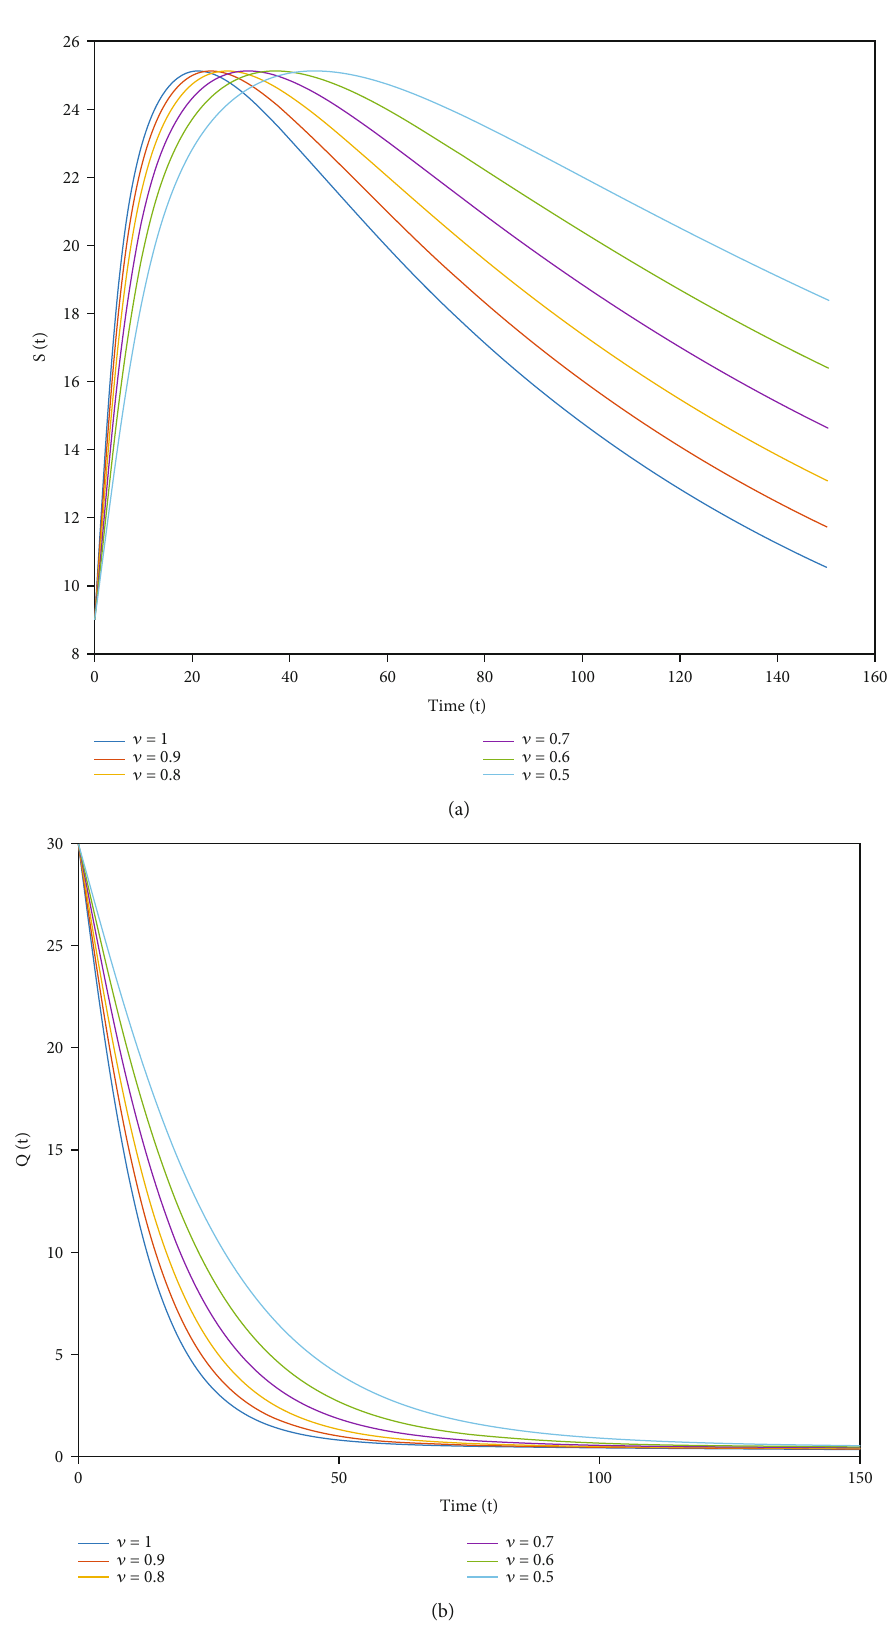
Figure 10: The simulation of the functions S ð t Þ and Q ð t Þ during the time t for di ff erent fractal dimensions ν = 1,0 : 9,0 : 8,0 : 7,0 : 6,0 : 5 and fractional order ω = 0 : 97